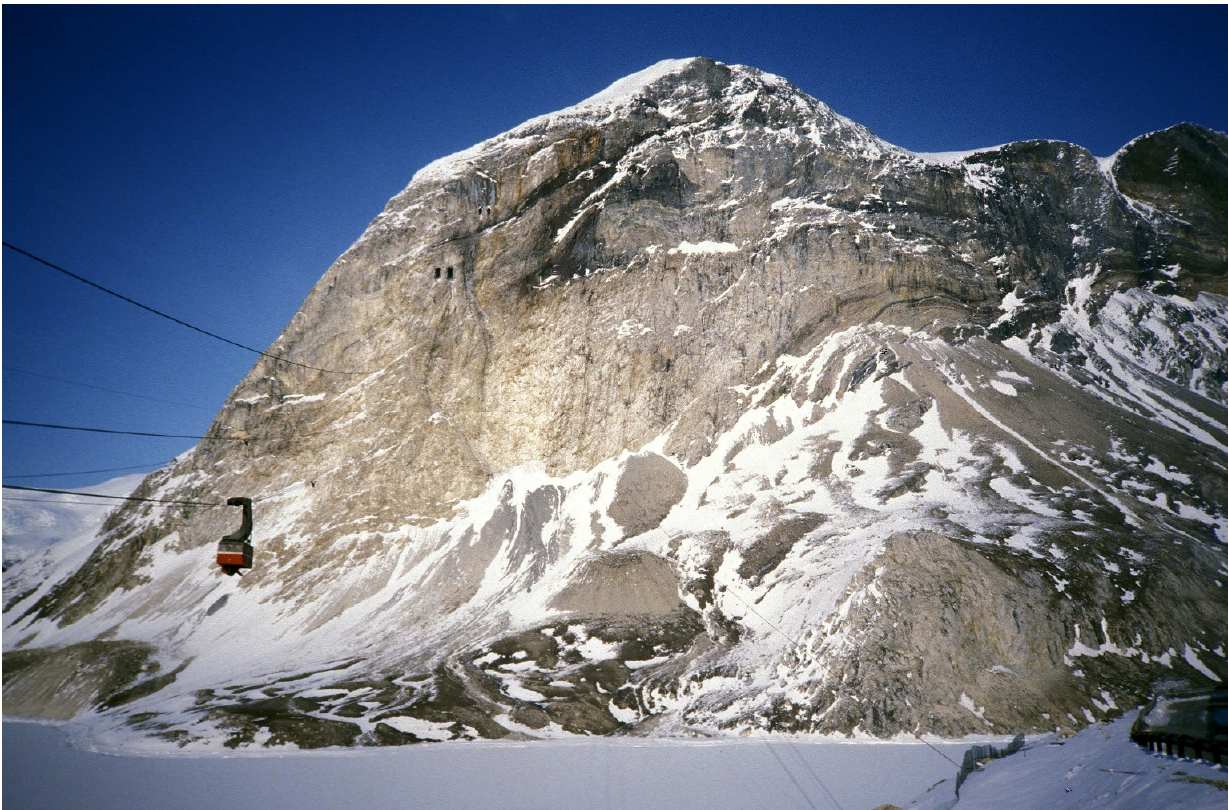
Figure 3. Historical photo of the Black Angel mine. Note the cable-car going toward the mine entrances at ca. 600 m elevation, close to angel-like shape of the black pelites. The Maarmorilik mine town is located at the bottom right of the picture.